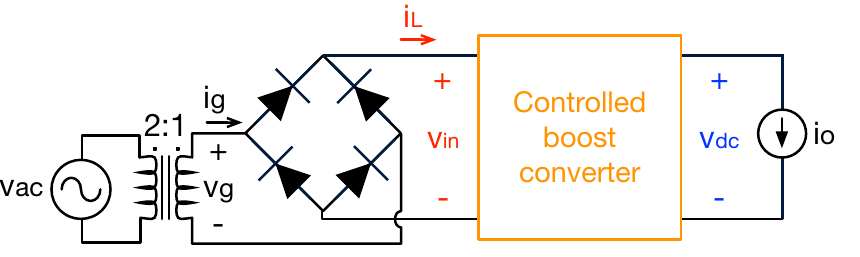
Figure 9. Scheme of the application example.